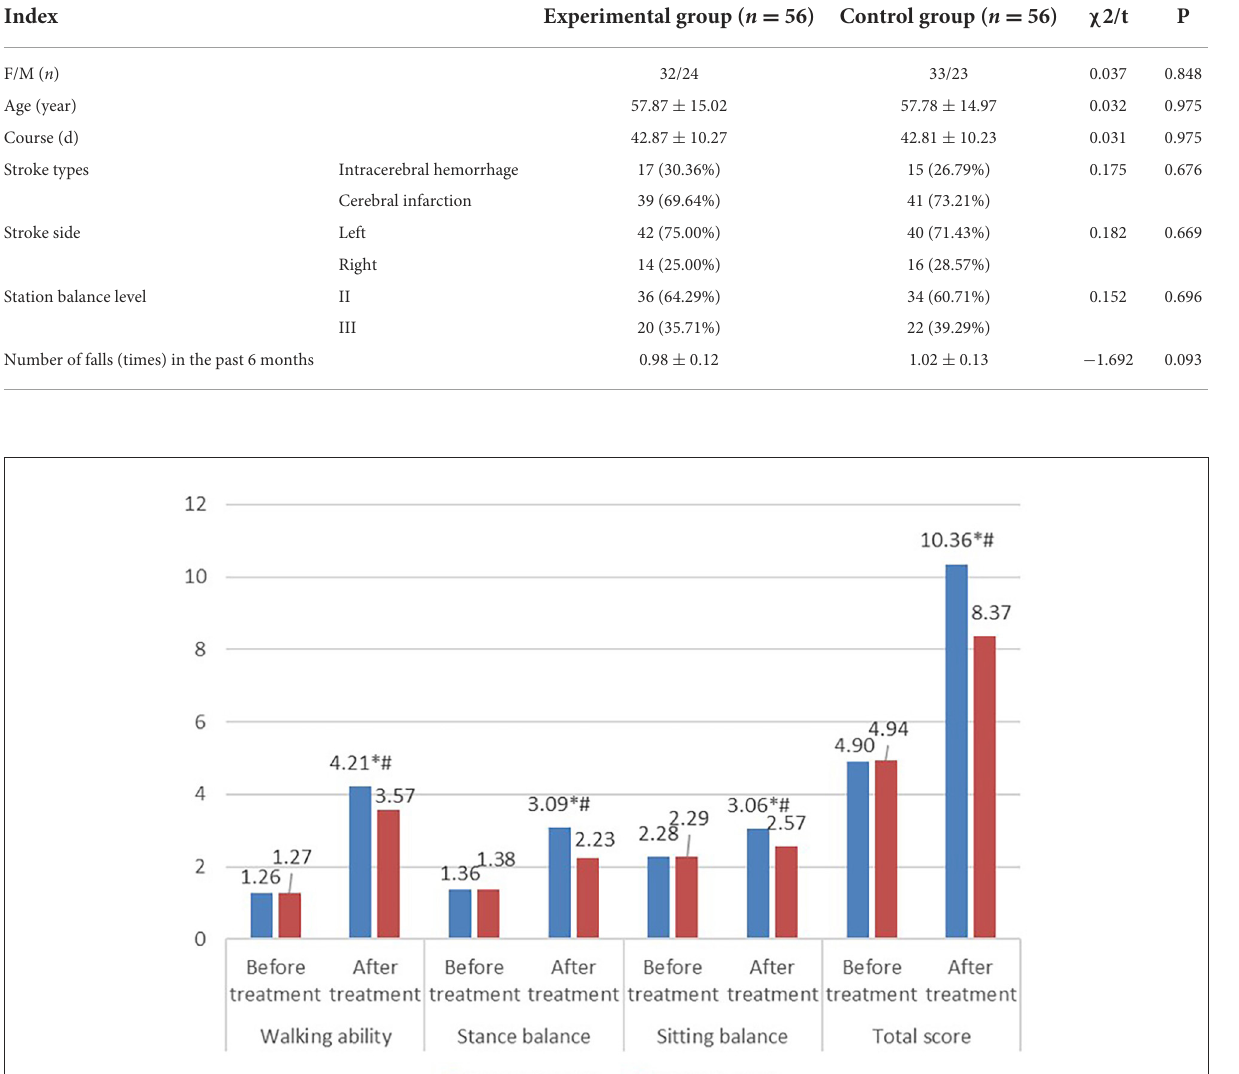
TABLE 1 Comparison of general data between the two groups.